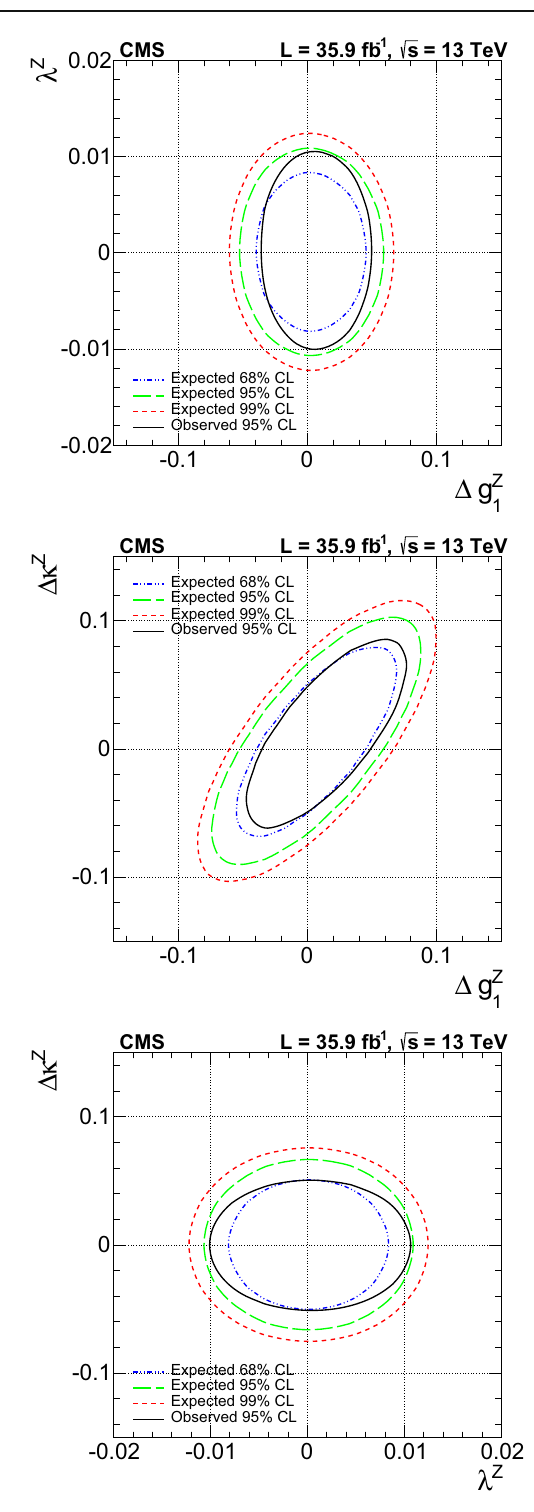
Fig. 12 Expected and observed two-dimensional limits on the ATGC effective Lagrangian (LEP parametrization) parameters at 95% CL